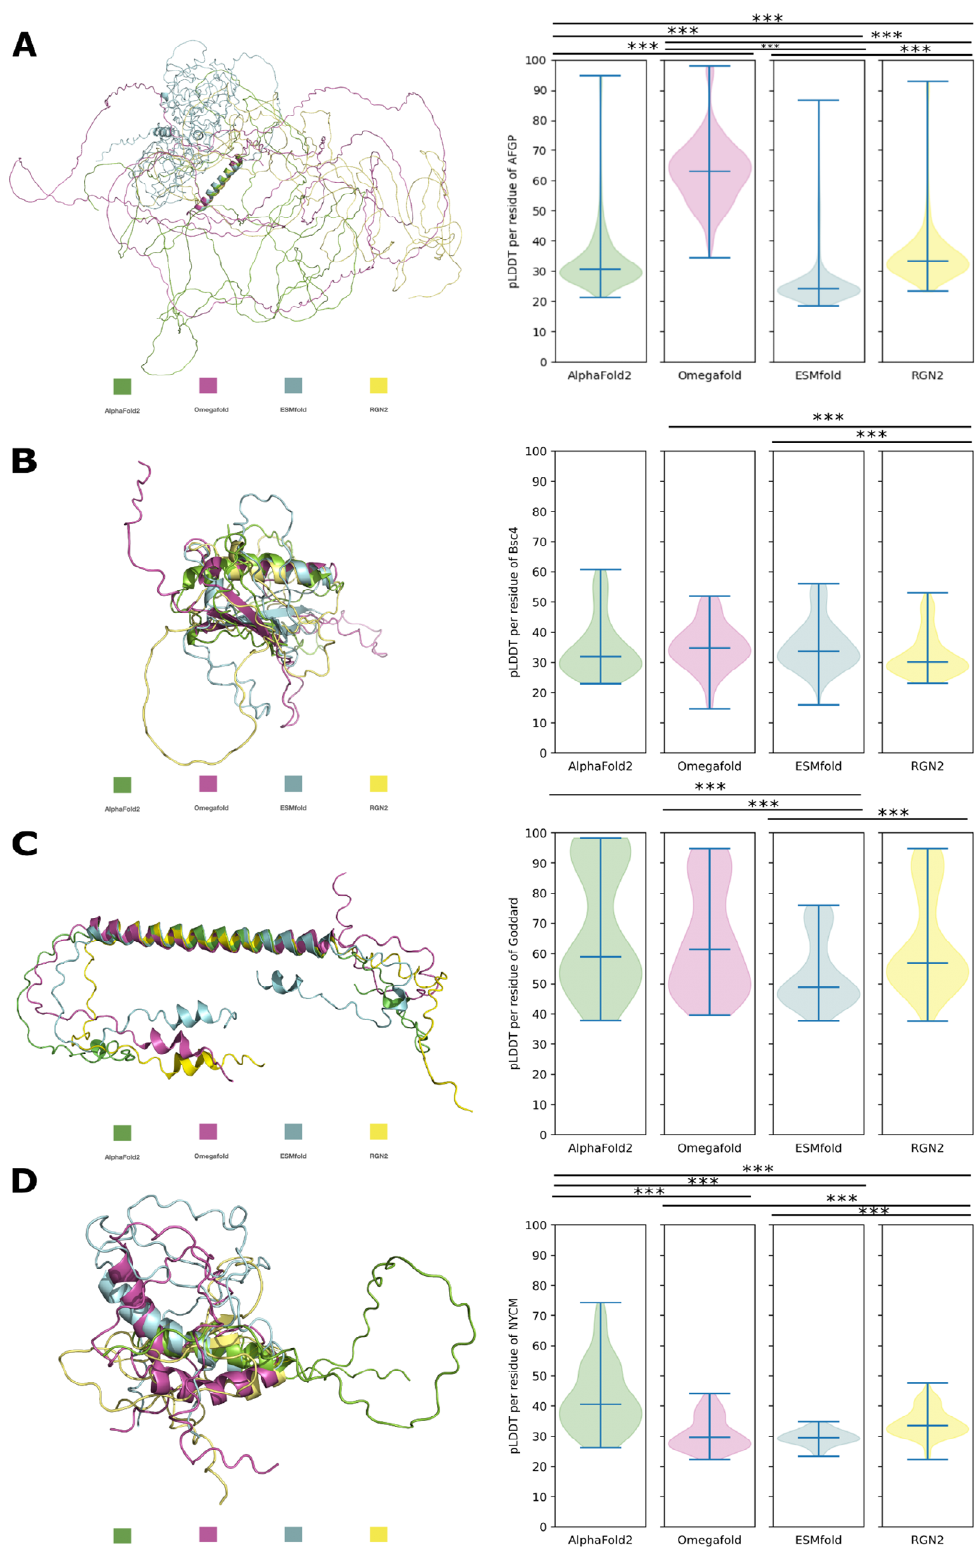
Figure 3. Comparison of different structure predictions for de novo proteins: Structural alignment of all models to a respective secondary element of the AF2 prediction and violin plots of pLDDT per residue of each model. A: AFGP, to α -helix (M1-A28), C α -RMSD = 0.663Å. B: Bsc4, to α -helix (K62-R83), C α -RMSD = 1.603Å. C: Goddard, to α -helix (S38-I80), C α -RMSD = 0.770Å. D: NCYM, to α -helix (N50-E66), C α -RMSD = 5.278Å. Significant difference in pLDDT is indicated by *** (p-value <